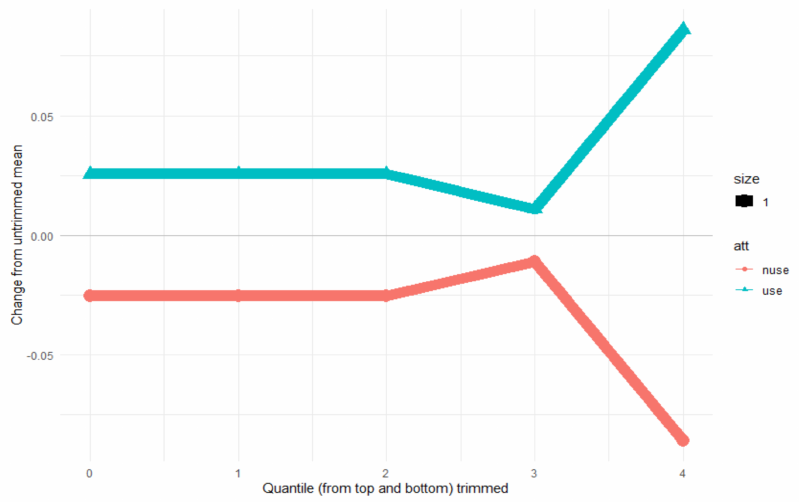
Figure 6. Changes of aggregated weights based on quantile of data trimmed (use/non-use values).